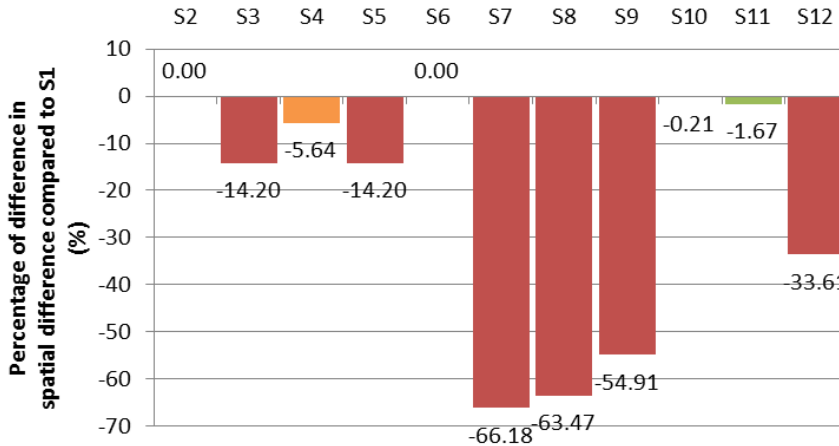
Figure 11. Deviation of spatial difference of all scenarios in relation to S1 ( =